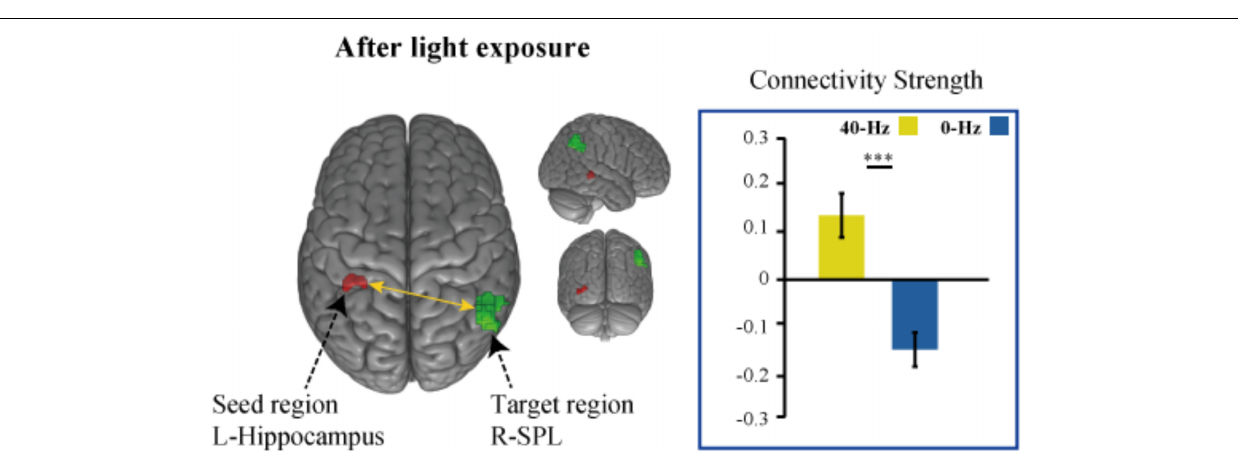
FIGURE 6 | Intergroup differences in light-exposure-induced strength of functional connectivity between the left hippocampus and SPL. The functional connection between hippocampus and SPL enhanced after 40-Hz light exposure but not 0-Hz light exposure. ∗∗∗ P <